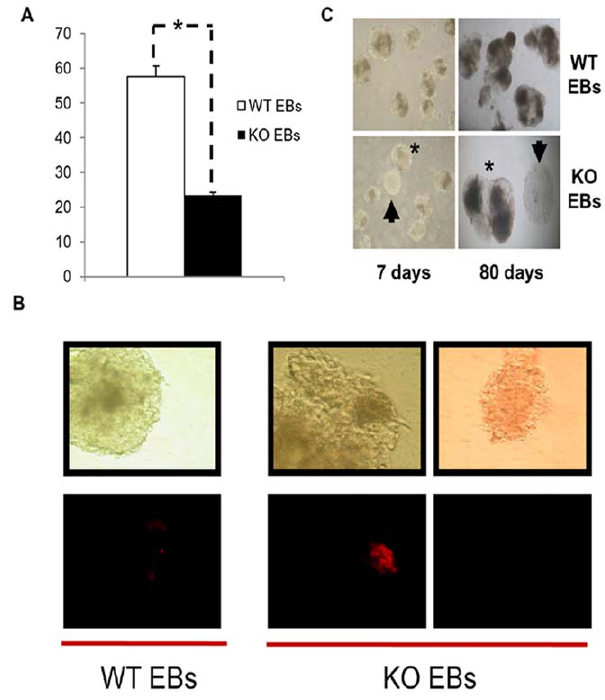
Figure 1. Apoptotic and macroscopic effects produced by the delection of Prnp . A) Comparing the numbers of EBs in the WT and KO lines (* P , 0.05. Error bars, s.e.m.; ‘‘Y’’ axis represents ‘‘number of EBs per plate’’) B) TUNEL analysis of wild type (WT) and Prnp -null (KO) embryoid bodies (EBs). C) Morphology of EBs on Day 7 and Day 80 of differentiation. The KO ESC line produced 2 types of EBs: one similar to WT (*) and the other called PGC- like KO EBs (arrowheads).